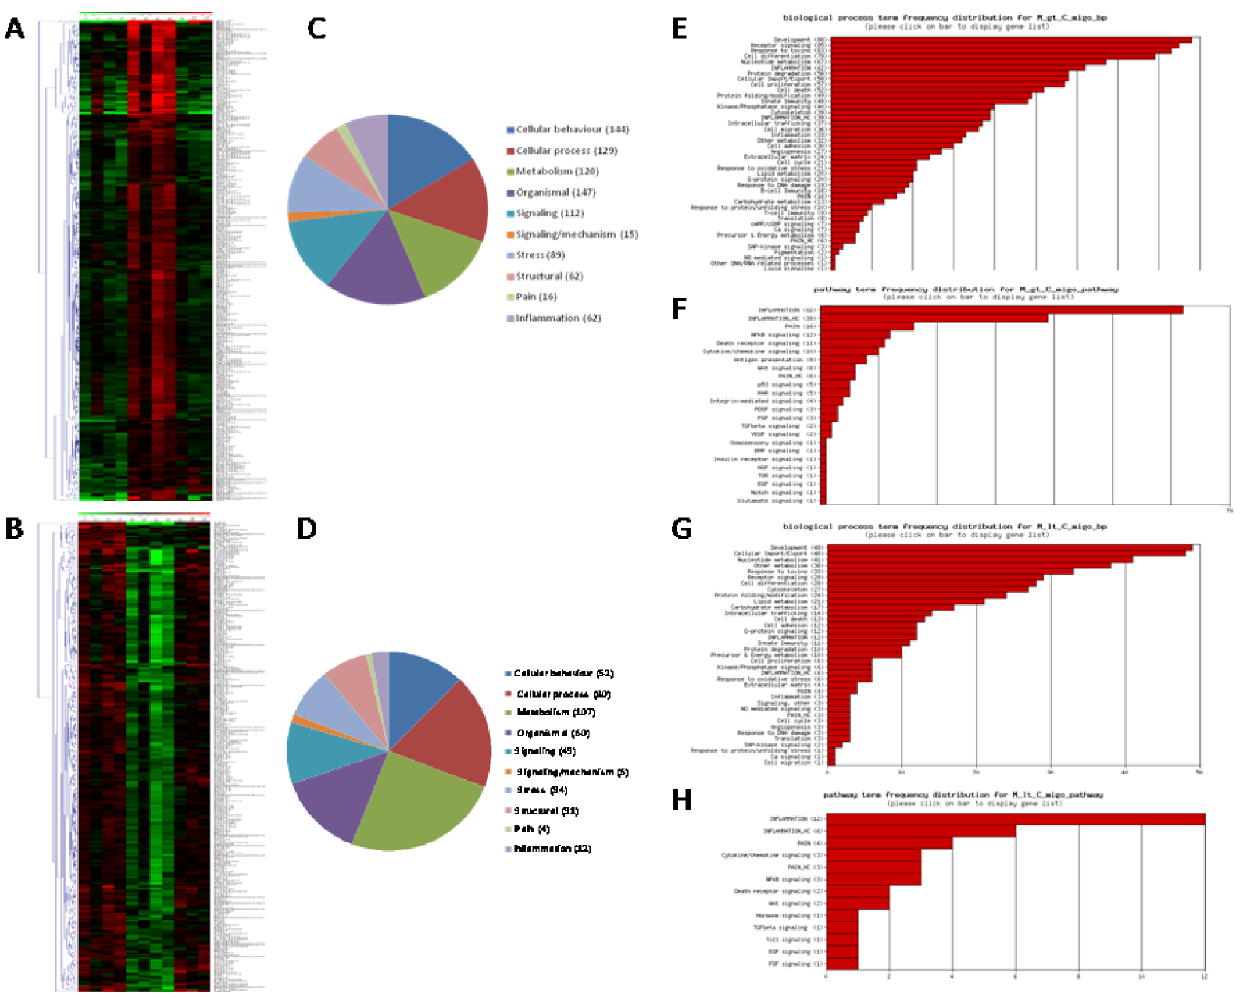
Figure 3. DGA and functional analysis of the effect of NMS on gene expression. (A–B) Heat maps of the significant genes (p , 0.05 and 2- fold up- or downregulation) in NMS rats (Group M, lanes M5–M8) in comparison to VSL # 3 treated NMS rats (Group C, lanes C1–C4). In comparison to